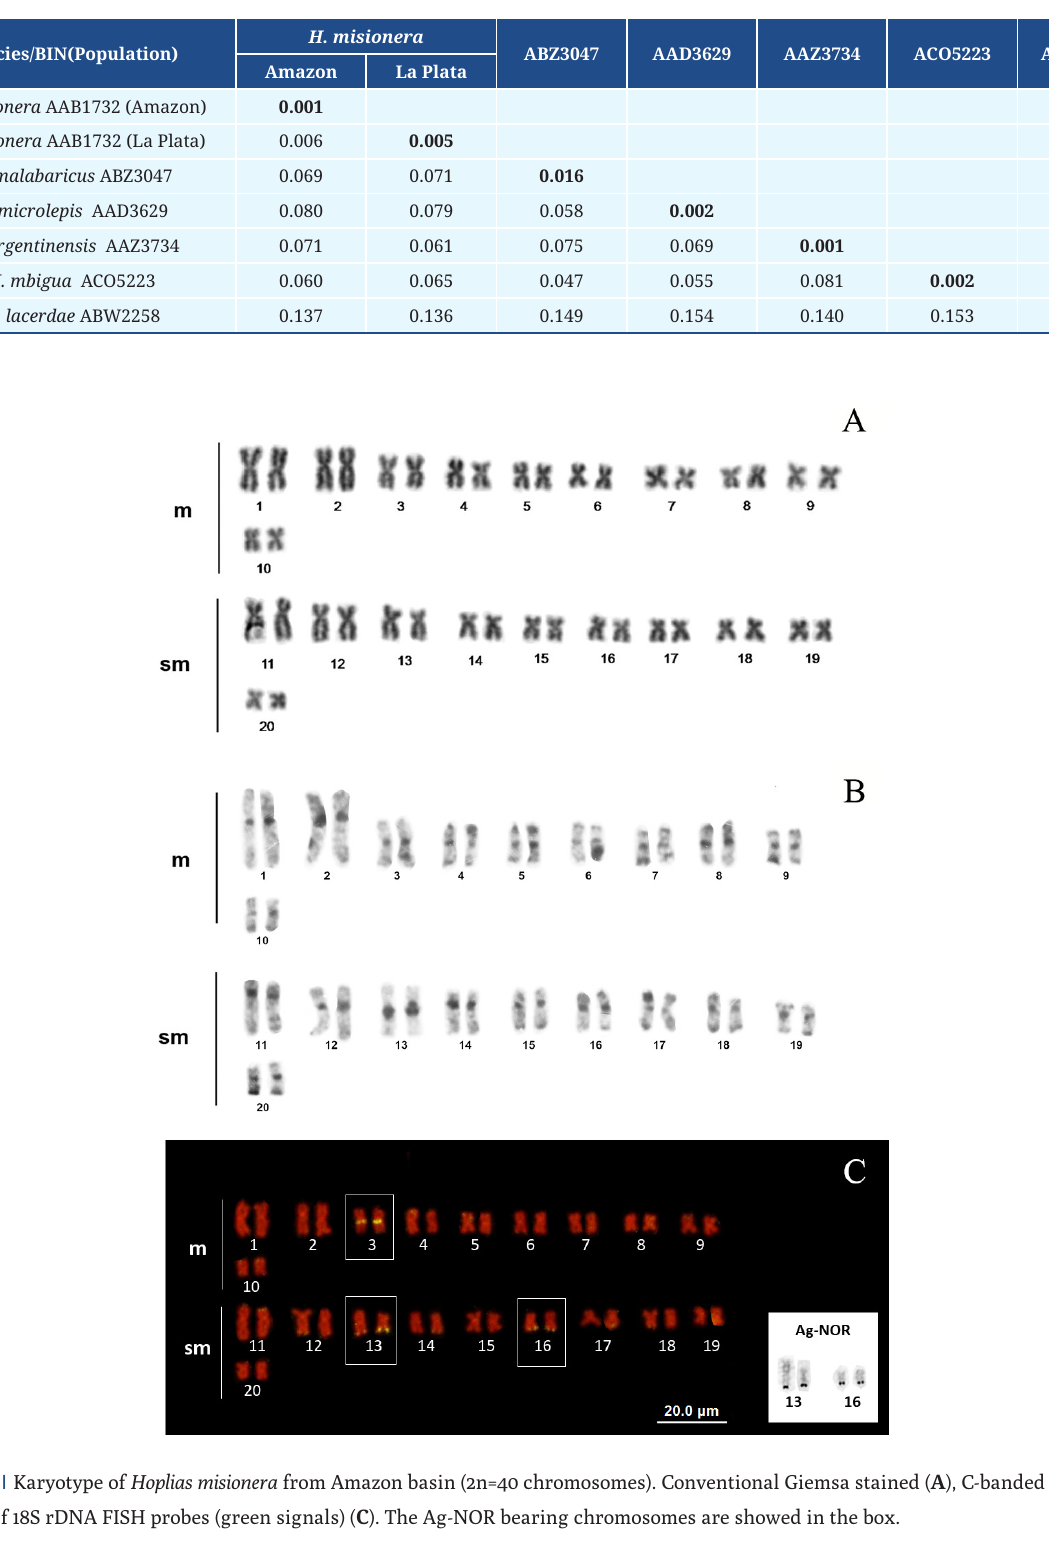
TABLE 3 | Mean genetic distances (Kimura 2-parameter model) between Hoplias clusters. Bold values indicate the mean intraspecific distances.